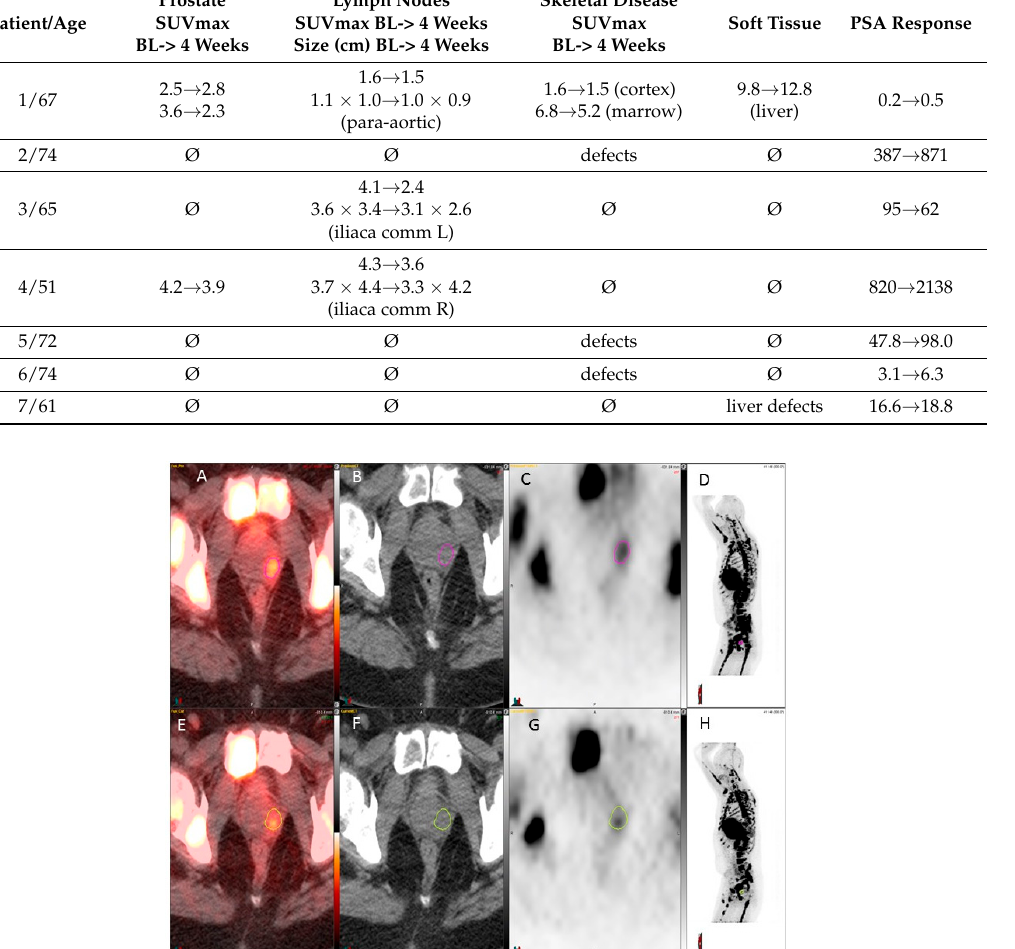
Table 1. Positron emission tomography/computerized tomography (PET/CT) changes in patients with prostate cancer on MET inhibitor therapy. Fluorine-18 fluorothymidine ( 18 F-FLT) SUVmax value changes are presented at baseline and after 4 weeks of treatment in different organs. Ø: No findings.